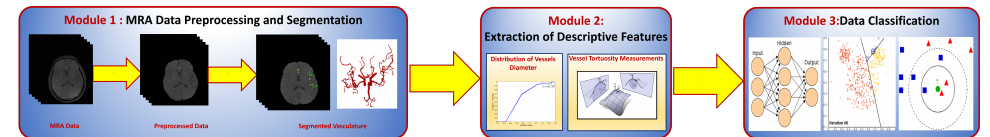
Figure 1. A block diagram showing different modules of the proposed CAD system for classifying hypertension